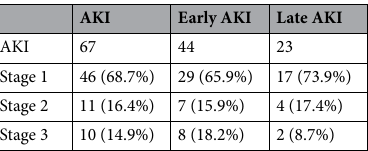
Table 1. Frequency of postoperative acute kidney injury. AKI: acute kidney injury.